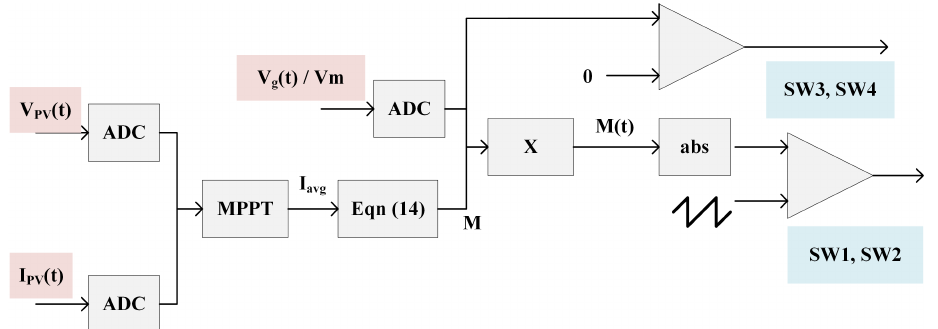
Figure 8. Block diagram of the control technique used for